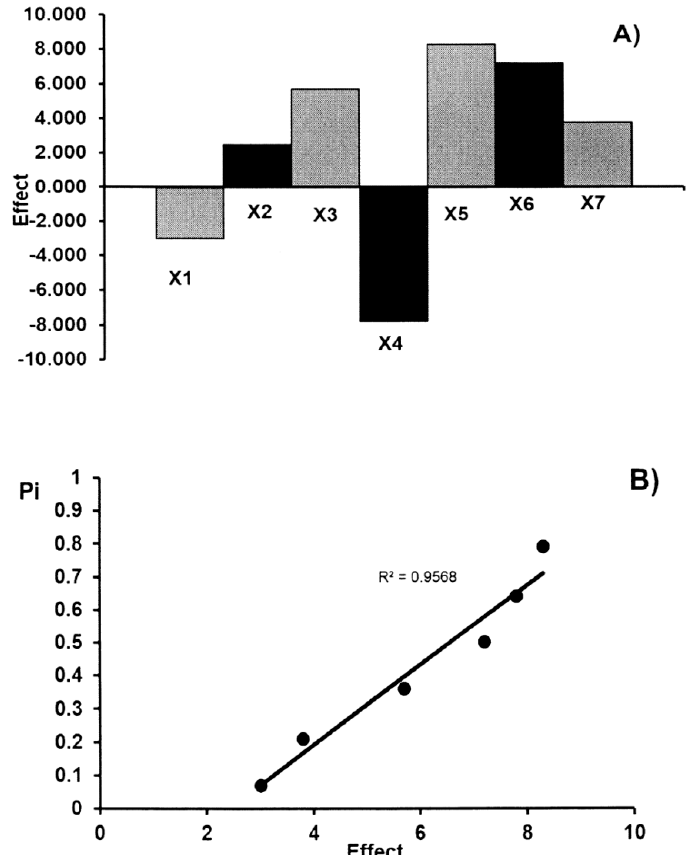
Figure 4. The robustness test: the effects of factors ( A ) and half-normal probability plot of effects ( B ) for the determination of ascorbic acid in commercial effervescent tablets.